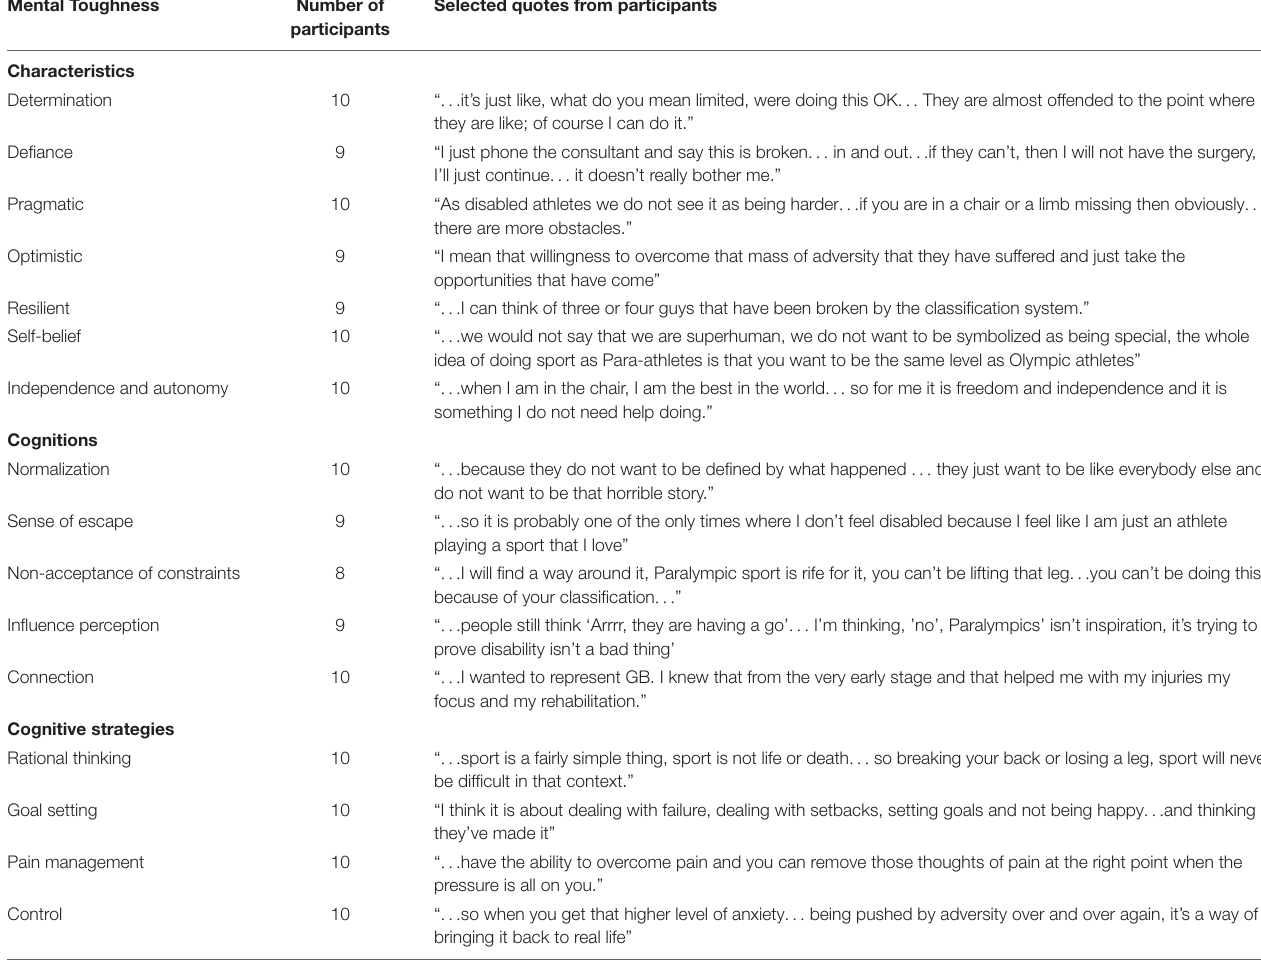
TABLE 1 | Summary of themes and examples of raw data extracts for MT conceptualization in Paralympians. Mental Toughness Number of Selected quotes from participants